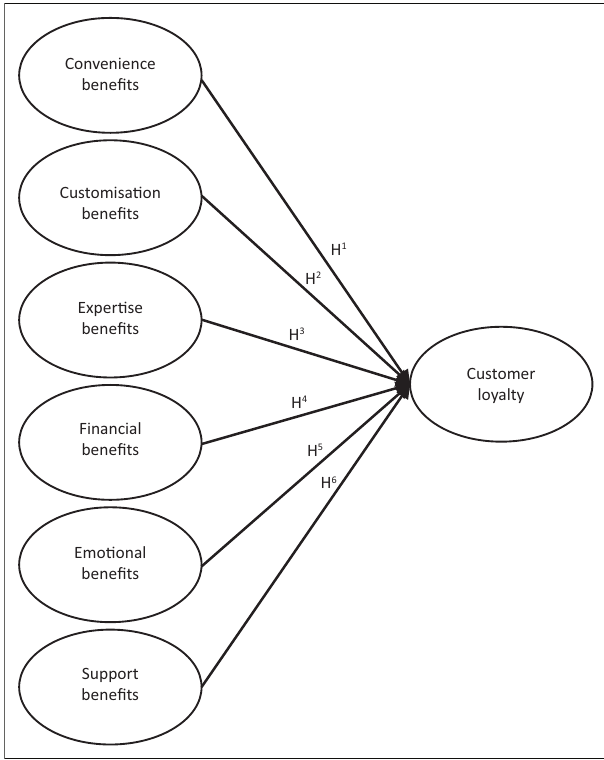
FIGURE 1: The hypothesised relationships of the perceived benefits with customer